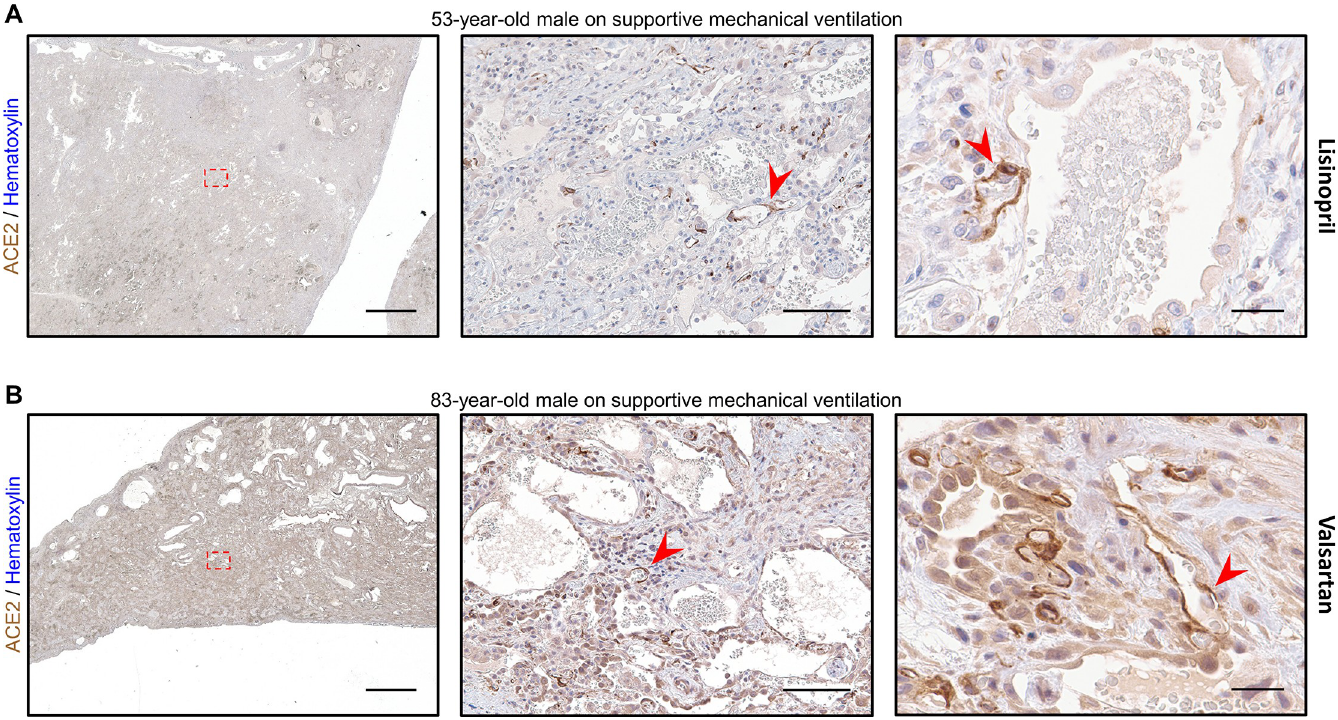
Fig 5. Two patients on ACEI/ARB therapy exhibit intense endothelial ACE2 expression. A) Representative images of lung stained for ACE2 from a 53-year-old man with organizing diffuse alveolar damage superimposed on fibrosing interstitial lung disease are shown using a 1x objective (left, scale bar 3mm) with the region outlined by the red dashed box magnified at low power (middle, scale bar 200 μ m) and second field at high power (right, scale bar 50 μ m). AT2 cell hyperplasia can be seen with lower level ACE2 expression present along the alveolar septum (green arrowheads). Strongly stained endothelial cells (red arrowheads) can be seen throughout the entire specimen from this patient who was on daily lisinopril at the time of specimen collection. B) Representative images of lung stained for ACE2 from an 83-year-old man in the organizing phase of diffuse alveolar damage are shown using a 1x objective (left, scale bar 3mm) with the region outlined by the red dashed box magnified at low power (middle, scale bar 200 μ m) and second field at high power (right, scale bar 50 μ m). In addition to high ACE2 expression in reactive AT2 cells (green arrowheads), strong staining can be seen in numerous vascular endothelial cells (red arrowheads) throughout the thickened septal area in this patient on valsartan 4 days prior to specimen collection. Sections were stained for ACE2 using DAB and counterstained with